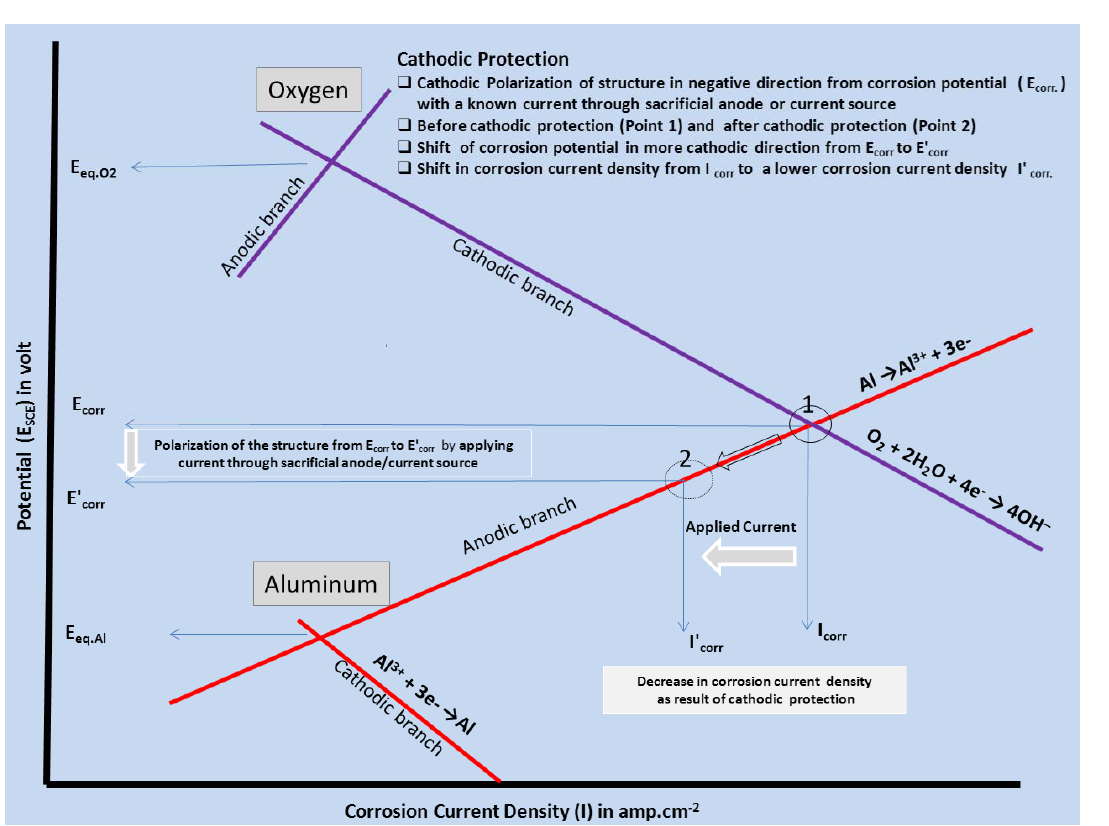
Figure 3. Evans diagram explaining the principle of cathodic